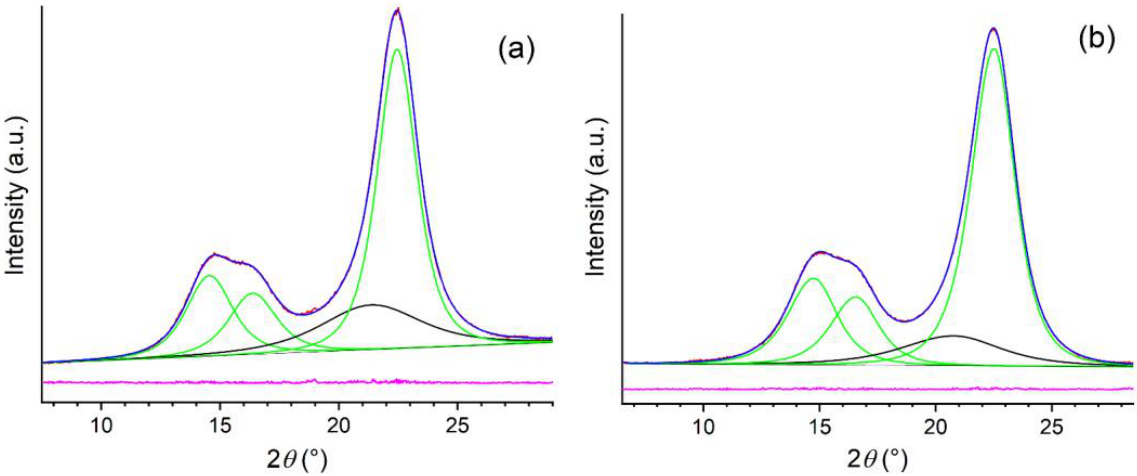
Figure 6. Profile fits of XRD patterns of CNC-EN ( a ), and CNC-CH ( b ), in which the individual diffraction peaks of cellulose I β are in green, the contribution of the amorphous fraction is in black, the experimental pattern is in red, the global profile fit is blue, and their difference is in pink.